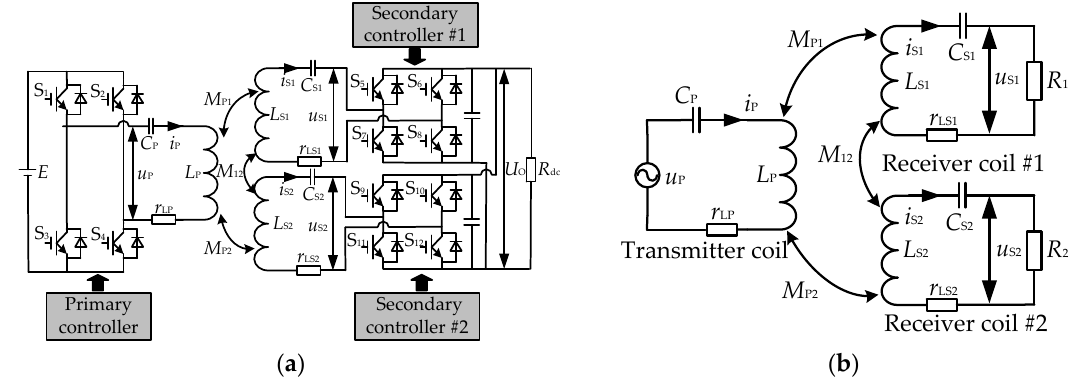
Figure 2. An IPT system based on dual-receiver: ( a ) The structure of dual-receiver IPT system; ( b ) The equivalent circuit of dual-receiver IPT